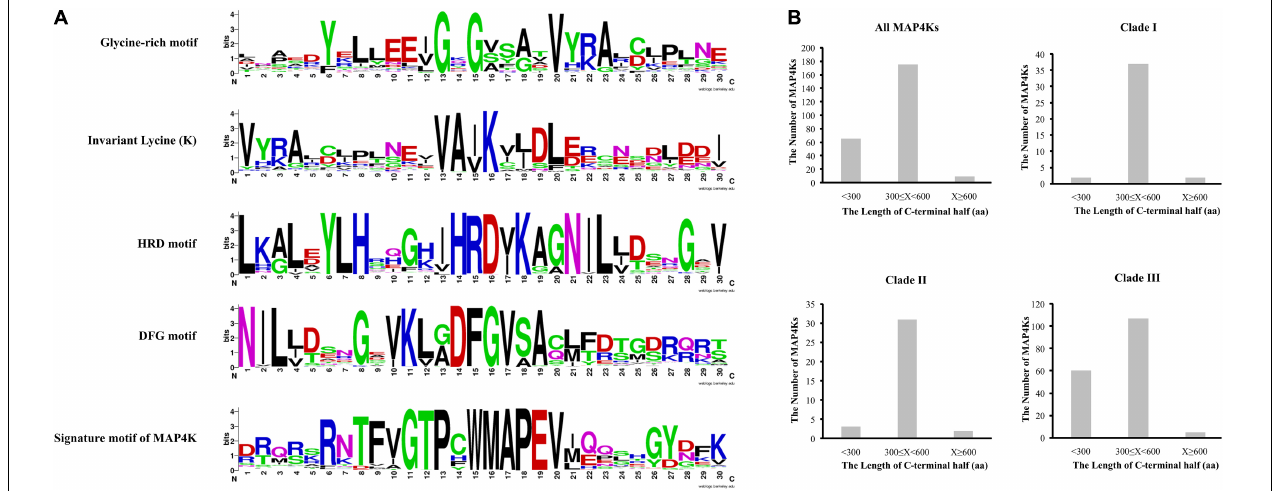
FIGURE 2 | MAP4K features. (A) Sequence logos of main conserved motifs. (B) Length of C-terminal half for all MAP4Ks and indicated